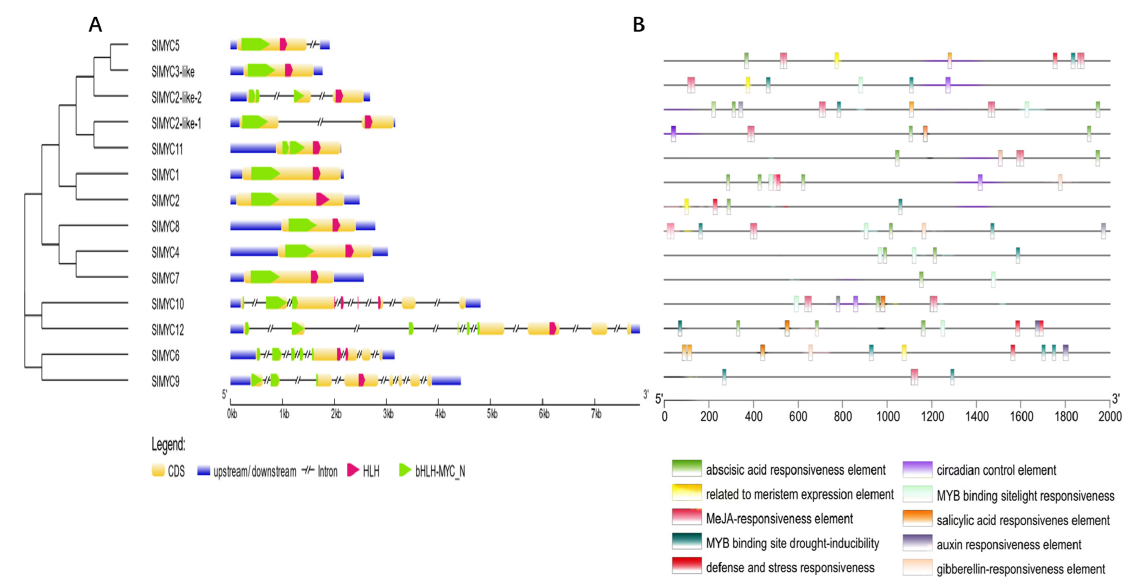
Figure 4. Analysis of exon–intron structures and cis-regulatory elements of SlMYC genes. ( A ) Exon– intron organization of MYC genes in Solanum lycopersicum (Sl) grouped according to their gene orthology. Blue and yellow bars indicate untranslated (UTR) regions and exons. Black interrupted lines indicate introns. The tree is rooted. ( B ) The number and composition of cis-acting regulatory elements in the promotor region of SlMYC genes. The 2000 base pair promoter region of each gene copy is displayed. Different colorful shapes show different elements.